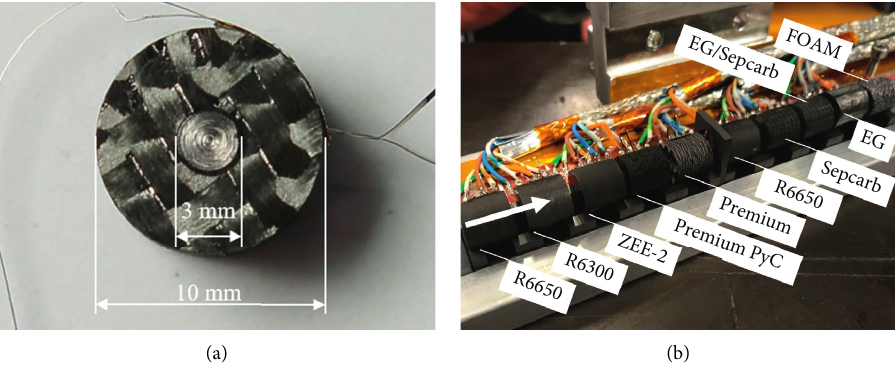
Figure 2: Front face of sample #5 SGL carbon premium with dimensions of the tantalum core ( � 3mm) and surrounding graphite ( ø 10 mm). The fiber reinforcement is clearly visible and is normal to the cylinder axis (a). Detailed view of the individual samples of target station 6. The arrow on the left indicates the beam direction. More information about the target materials is presented in Table 1